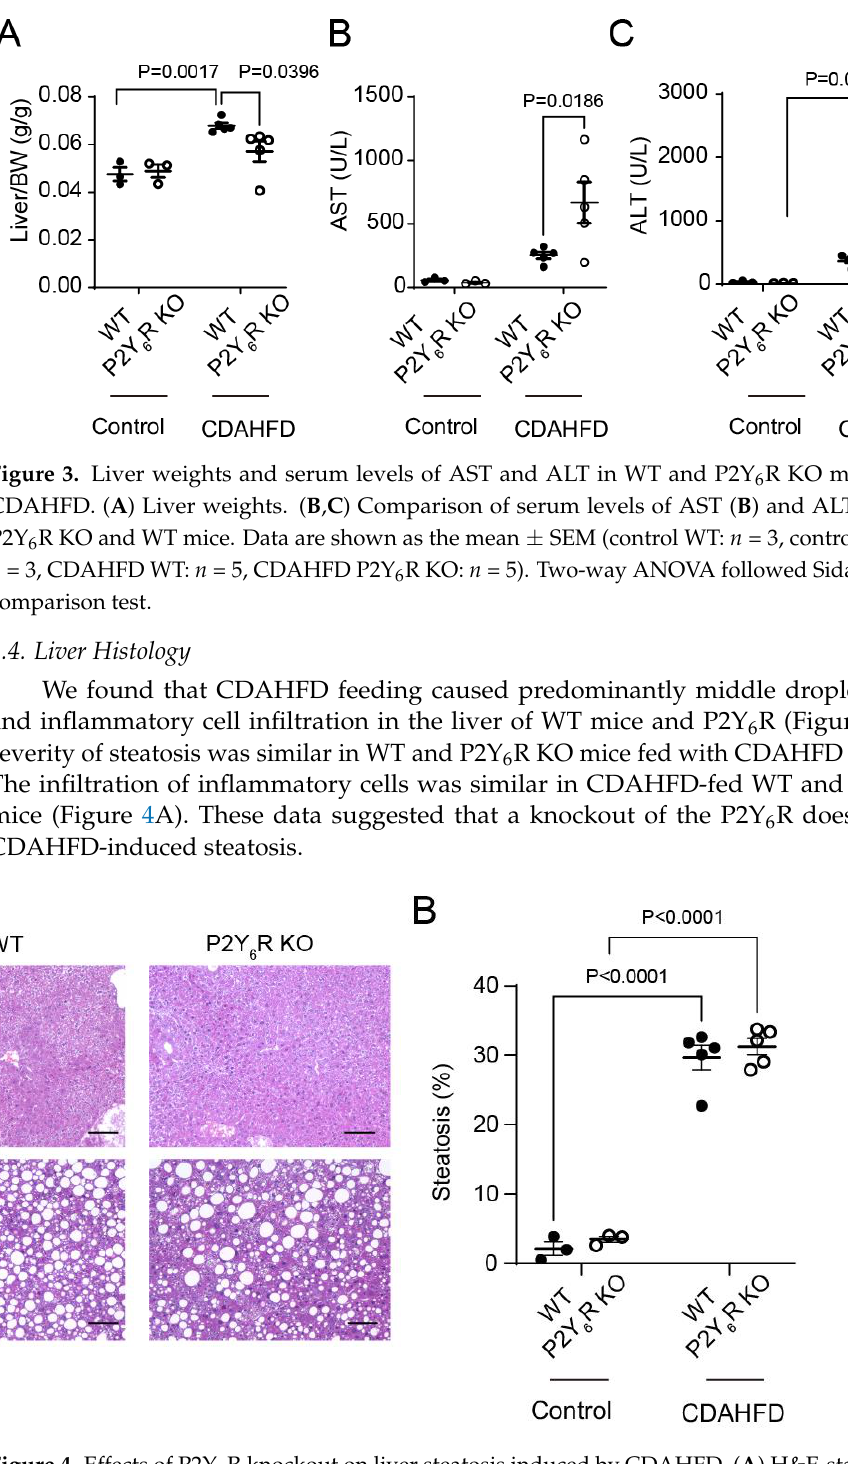
Figure 4. Effects of P2Y 6 R knockout on liver steatosis induced by CDAHFD. ( A ) H&E-stained images of liver sections. Scale bar: 100 µ m. ( B ) Liver steatosis. Data are shown as the mean ± SEM (control WT: n = 3, control P2Y 6 R KO: n = 3, CDAHFD WT: n = 5, CDAHFD P2Y 6 R KO: n = 5). Two-way ANOVA followed Sidak’s multiple comparison